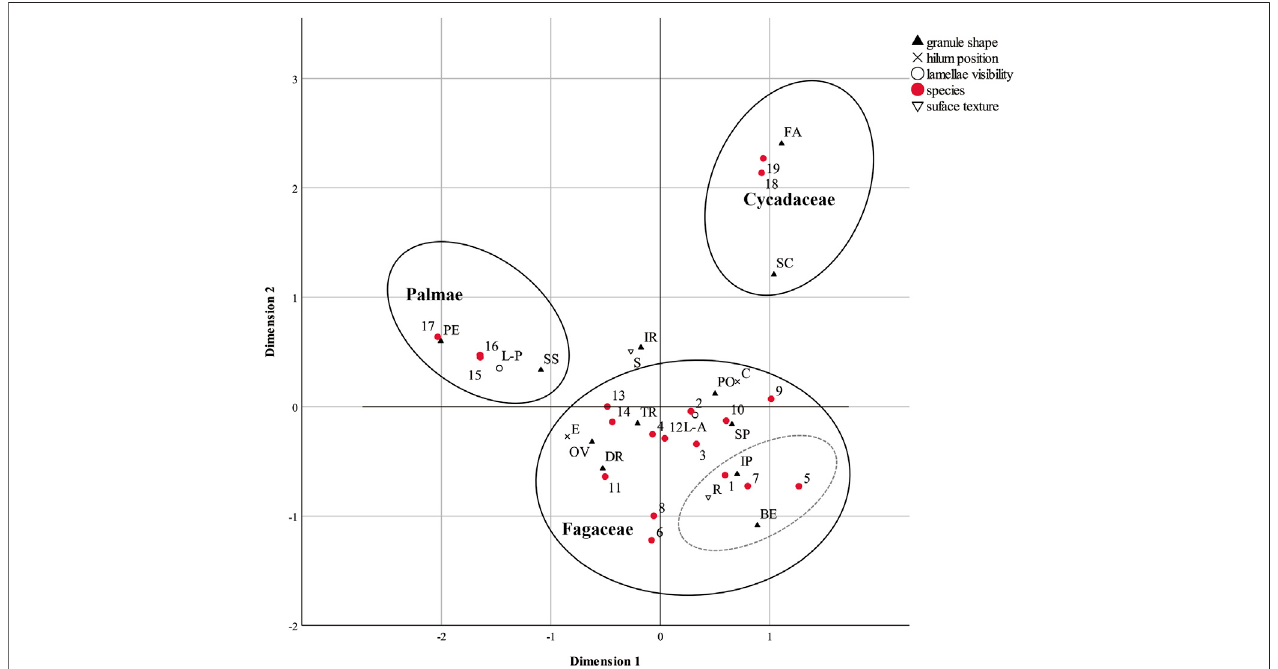
FIGURE 5 | MCA result of morphometric data of starches at the species level. Labels: Species: 1, Castanopsis platyacantha ; 2, Castanopsis hystrix ; 3, Castanopsis fargesii ; 4, Castanopsis sclerophylla ; 5, Cyclobalanopsis glauca ; 6, Cyclobalanopsis chapensis ; 7, Cyclobalanopsis gambleana ; 8, Cyclobalanopsis phanera ; 9, Lithocarpus cleistocarpus ; 10, Lithocarpus litseifolius ; 11, Quercus cocciferoides ; 12, Quercus oxyphylla ; 13, Quercus variabilis ; 14, Quercus franchetii ; 15, Arenga westerhouti i (white); 16, Arenga westerhoutii (red); 18, Caryota obtusa ; 18, Cycas pectinata ; 19, Cycas panzhihuaensis . Shapes: BE: bell shape, DR: drop shape, FA: faceted sphere, IP: irregular polyhedron, IR: irregular shape, OV: oval shape, PE: pestle shape, PO: polygonal shape, SP: sphere, SC: spherical cap, SS: spindle shape, TR: triangle. Lamellae visibility: L-A: lamellae absence, L-P: lamellae presence. Surface texture: R: rough surface, S: smooth surface. Ellipses are not statistical, but hand-drawn to isolate key woody plant forms (Acorns, Cycads, Palms).